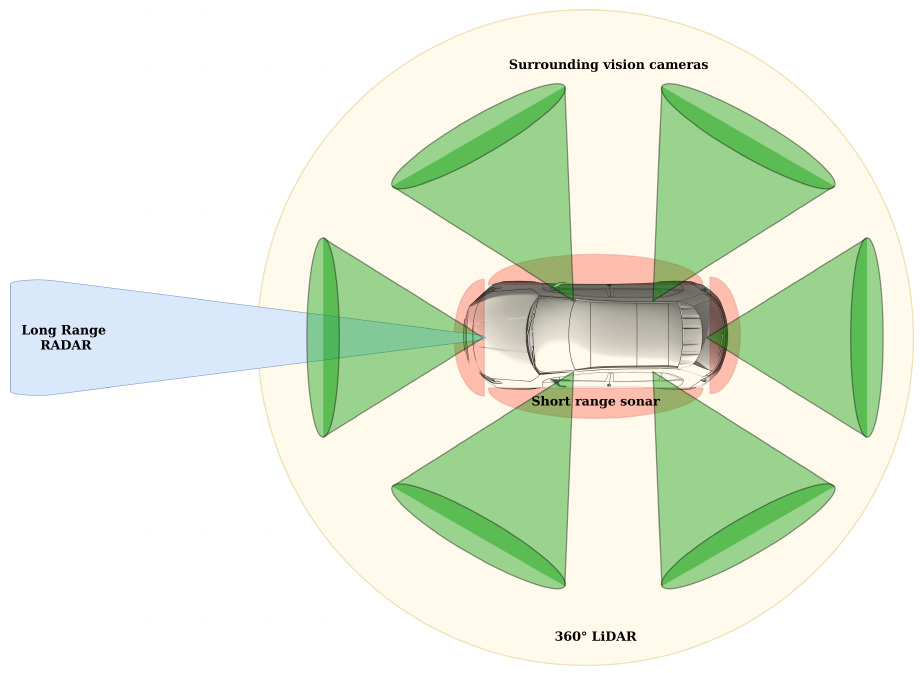
Figure 2. Typical sensor setup for driverless vehicles with each sensor’s field of view. Radar is denoted with blue, LiDAR with yellow, vision cameras with green, and short-range sonars with